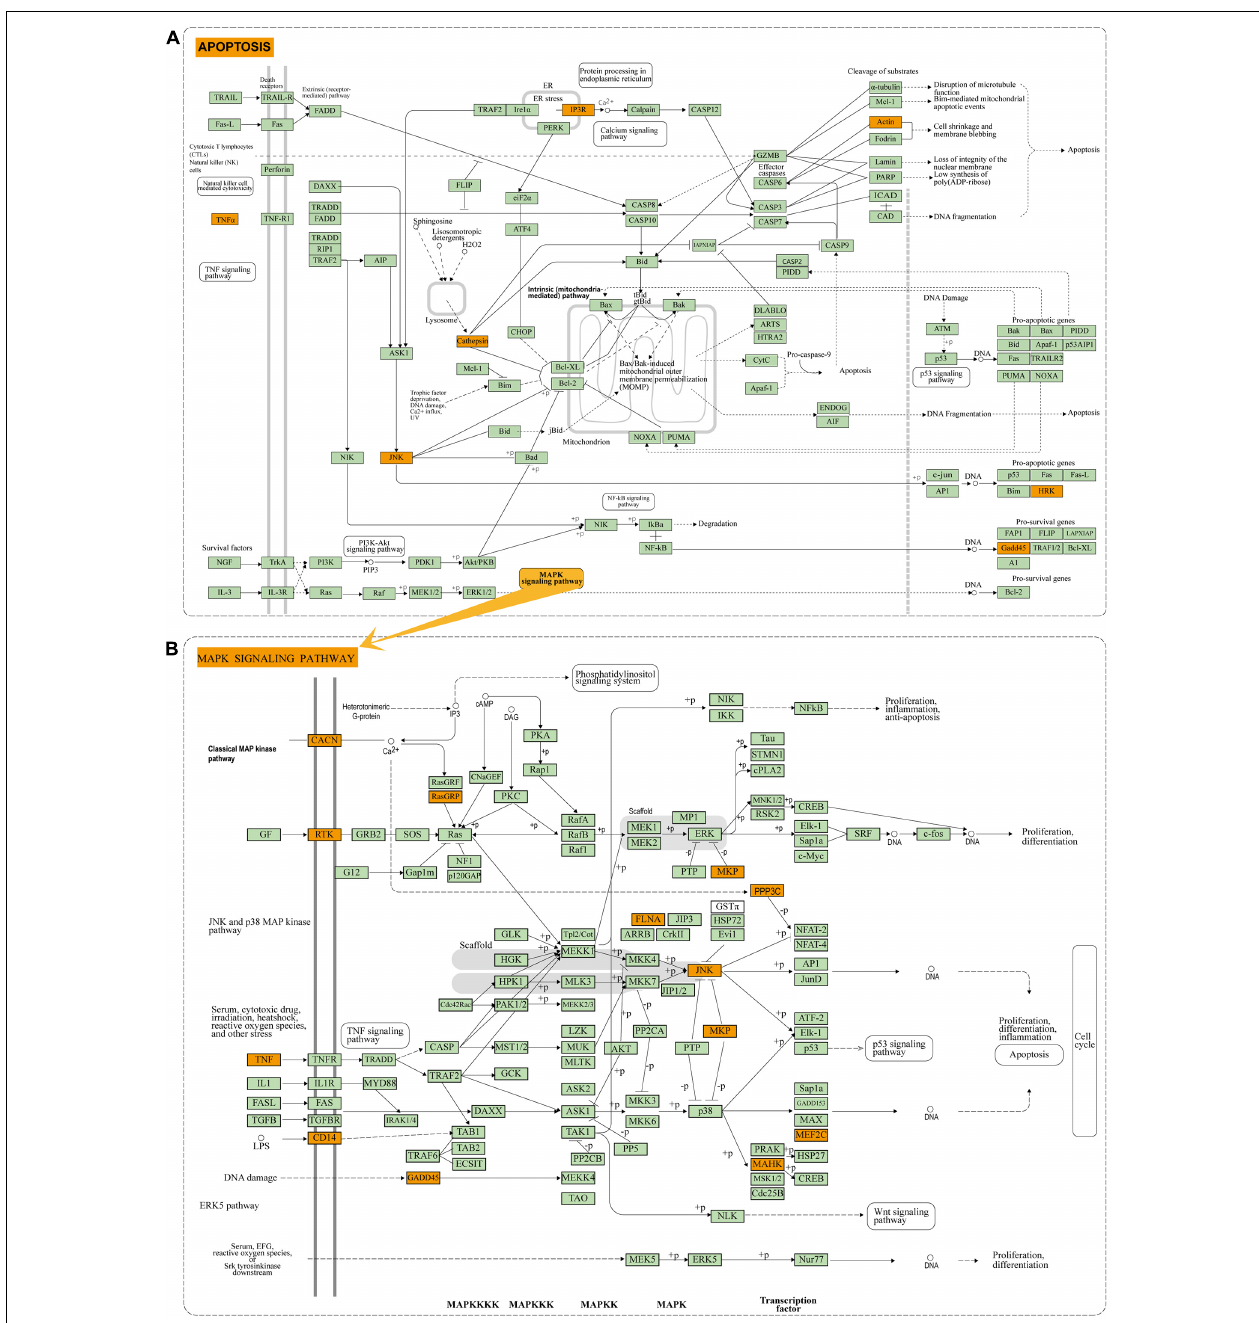
FIGURE 8 | Enrichment results of KEGG pathway: (A) Apoptosis pathway of DEmRNAs in down-regulated ceRNA network. (B) MAPK pathway of DEmRNAs in down-regulated ceRNA network. Orange module indicates the enriched DEmRNAs in the apoptosis and MAPK pathway.